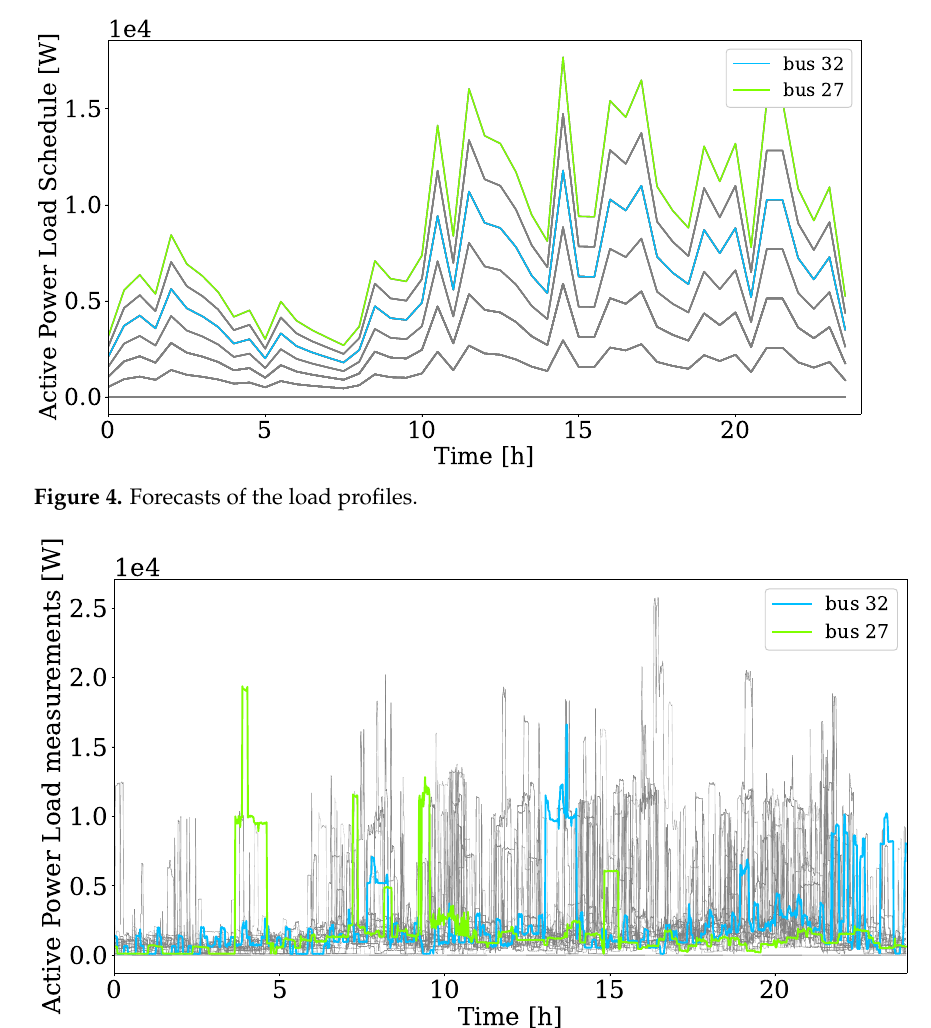
Figure 5. Measurements of the load